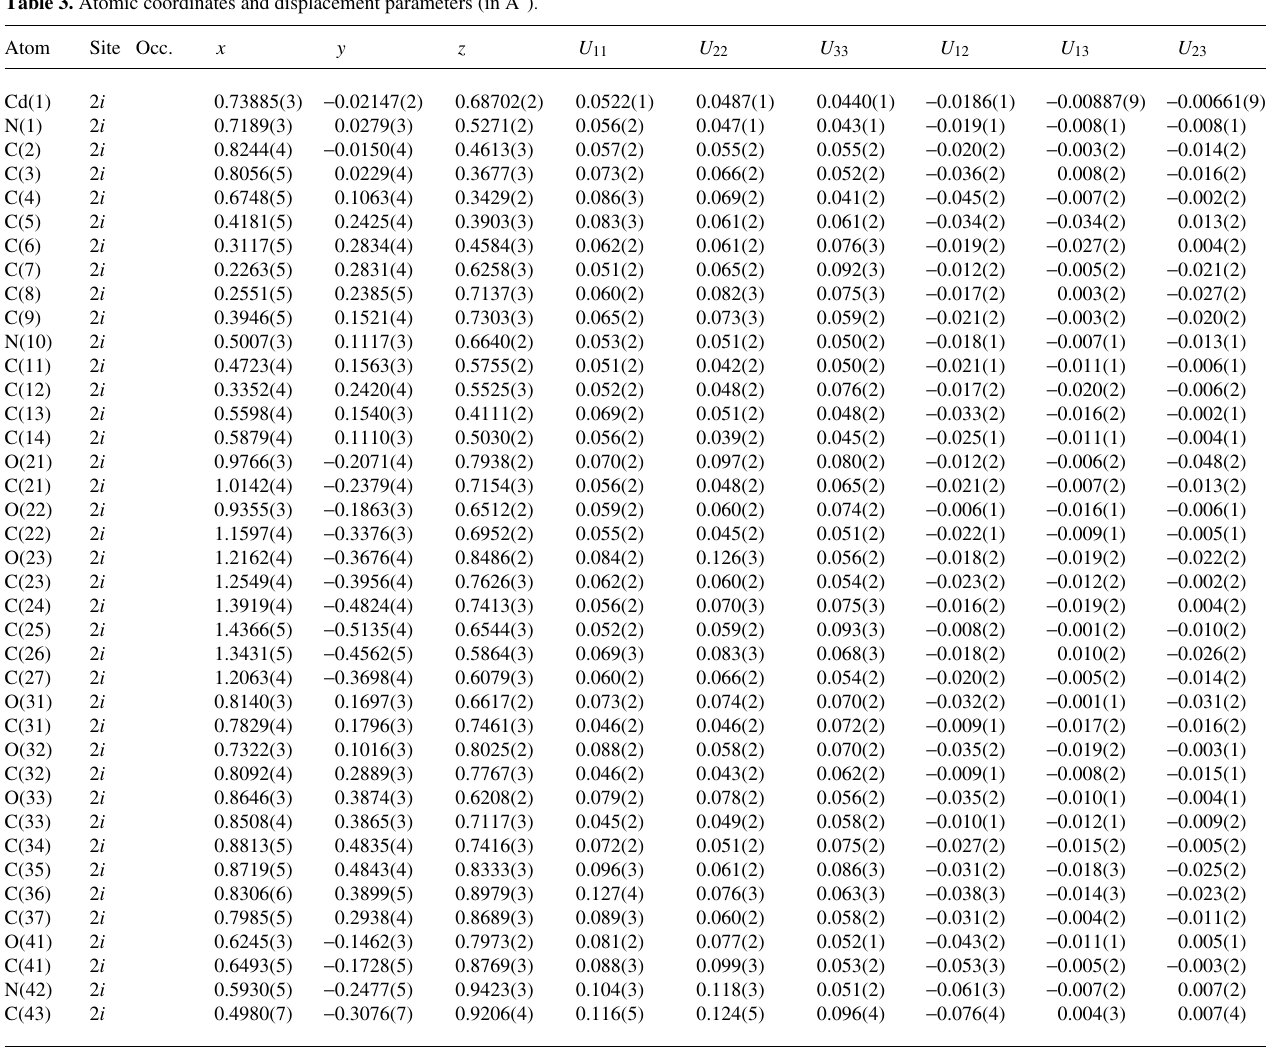
Table 3. Atomic coordinates and displacement parameters (in Å 2 ) .